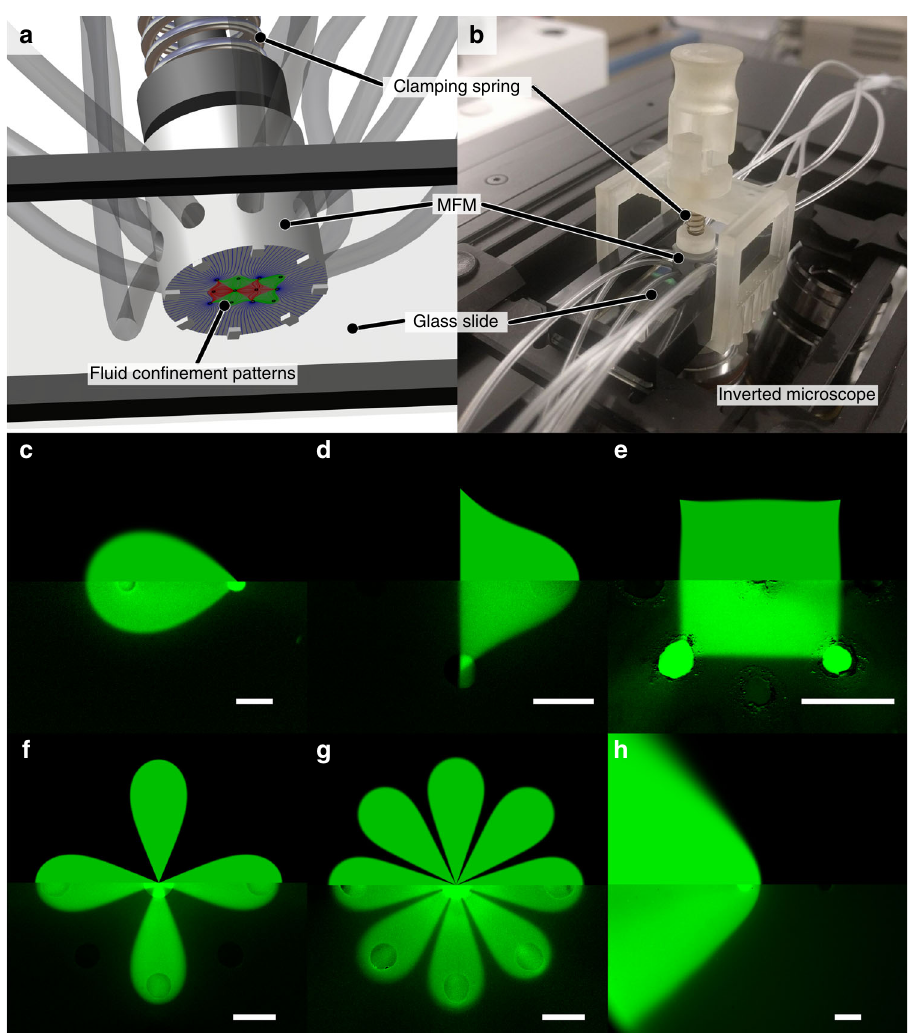
Fig. 3 Experimental setup and side-by-side comparison between theory and experiments. a Schematics of a fi xed MFM setup. The MFM is precisely positioned over the surface with a gap controlled by the spacers. b Picture of the experimental setup with holder and MFM clamped atop of an inverted microscope. c – f Side-by-side comparison between analytical and experimental results for various multipolar con fi gurations. The top half of each sub fi gure is the theoretical concentration pro fi le while the bottom half is a micrograph of a fl uorescent dye injected using the MFM (Pe ∼ 10 2 , Reynolds number ∼ 10 − 3 ). c Micro fl uidic dipole. d Micro fl uidic quadrupole. e Polygonal multipole ( f ) 4-petal axisymmetric “ fl ower ” multipole ( g ) 8-petal axisymmetric “ fl ower ” multipole ( h ) Asymmetric impinging fl ows of different concentrations. Scale bars = 500 µ